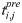
Hierarchical Bayesian network for the Newtonian interaction model.The model expresses the generative process of observed press-times ti,jpre across trials i, participants j, and pucks k including Weber-Fechner scaling given perceptual uncertainties of distance xi,j and mass mj,k of the pucks and subjects’ press-time variability. The parameter values refer to the prior probability distributions. See the text for details.